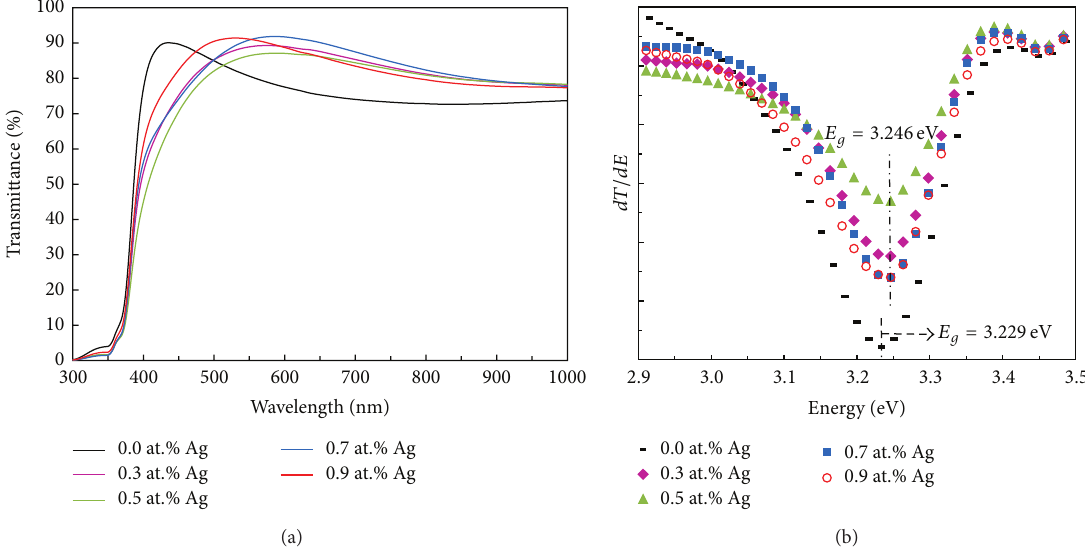
Figure 6: (a) UV-Vis. transmittance spectra of undoped and Ag doped ZnO thin films and (b) d T /d E plots of undoped and Ag doped ZnO thin